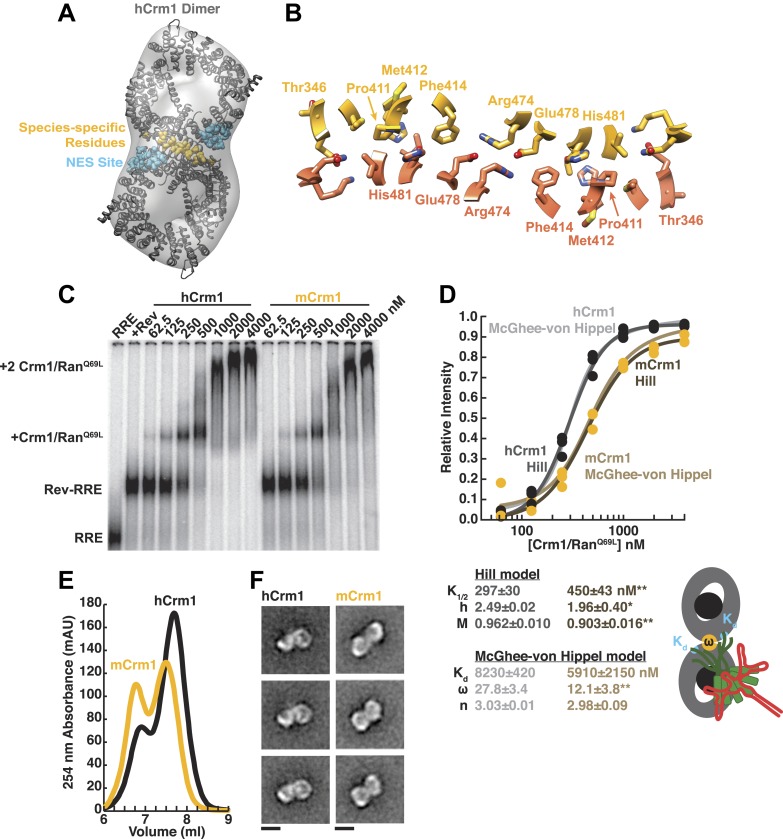
Species-specific residues define a Crm1 dimerization surface that enhances Rev-RRE binding.(A) A dimer of human Crm1 extracted from a unit cell of a Crm1-Snurportin1 complex that lacks RanGTP (PDB 3GB8) was fit into the EM reconstruction (grey envelope) of Crm1 and RanGTP bound to Rev-RRE (Figure 2—figure supplement 2). Residues that differ between murine and human Crm1 that enhance Rev-RRE activity (Sherer et al., 2011; Elinav et al., 2012) are shown in gold and form an interface between two Crm1 monomers (detailed in panel B and Figure 2—figure supplement 3). Two NES binding sites poised to engage two Rev NES peptides are shown in cyan. (C–D) Human Crm1 recognizes Rev-RRE with higher affinity and increased cooperativity compared to its murine ortholog, shown by gel mobility shift assays with radiolabeled RRE, a molar excess of Rev, and increasing concentrations of Crm1-RanGTP. The Hill equation or a version of the McGhee-von Hippel model (Epstein, 1978) was fit to the quantified data from three independent experiments (R2 > 0.99 for all models compared to average values) as shown in (D) and described in ‘Materials and methods’. Asterisks denote *p < 0.05 and **p < 0.01 from one-tailed t-tests. A schematic model of the complex is shown to highlight the physical meaning of the McGhee-von Hippel parameters. (E) Size-exclusion chromatograms of Rev-RRE complexes assembled with murine Crm1 or human Crm1 show that murine Crm1 elutes with a larger apparent mass, presumably due to a larger hydrodynamic radius in the absence of Crm1-Crm1 interactions. (F) Class averages of Rev-RRE complexes bound to a dimer of human (426 particles) or murine (617 particles) Crm1 from negatively-stained micrographs of particles from (E). Murine Crm1 particles showed a wider range of sizes than the human particles, with most being larger, and the murine particles showed different features, such as an hourglass shape with fewer details in the center of the particle than human Crm1 particles. Scale bars show 10 nm.